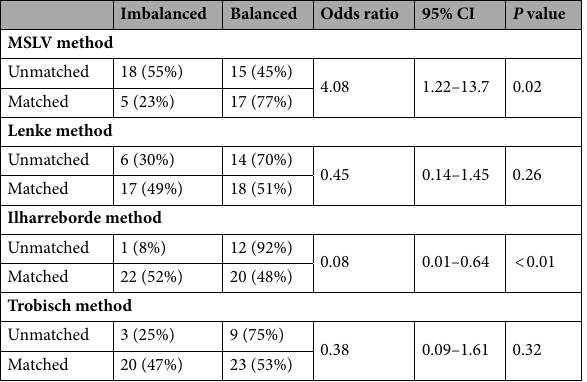
Imbalanced Balanced Odds ratio 95% CI P